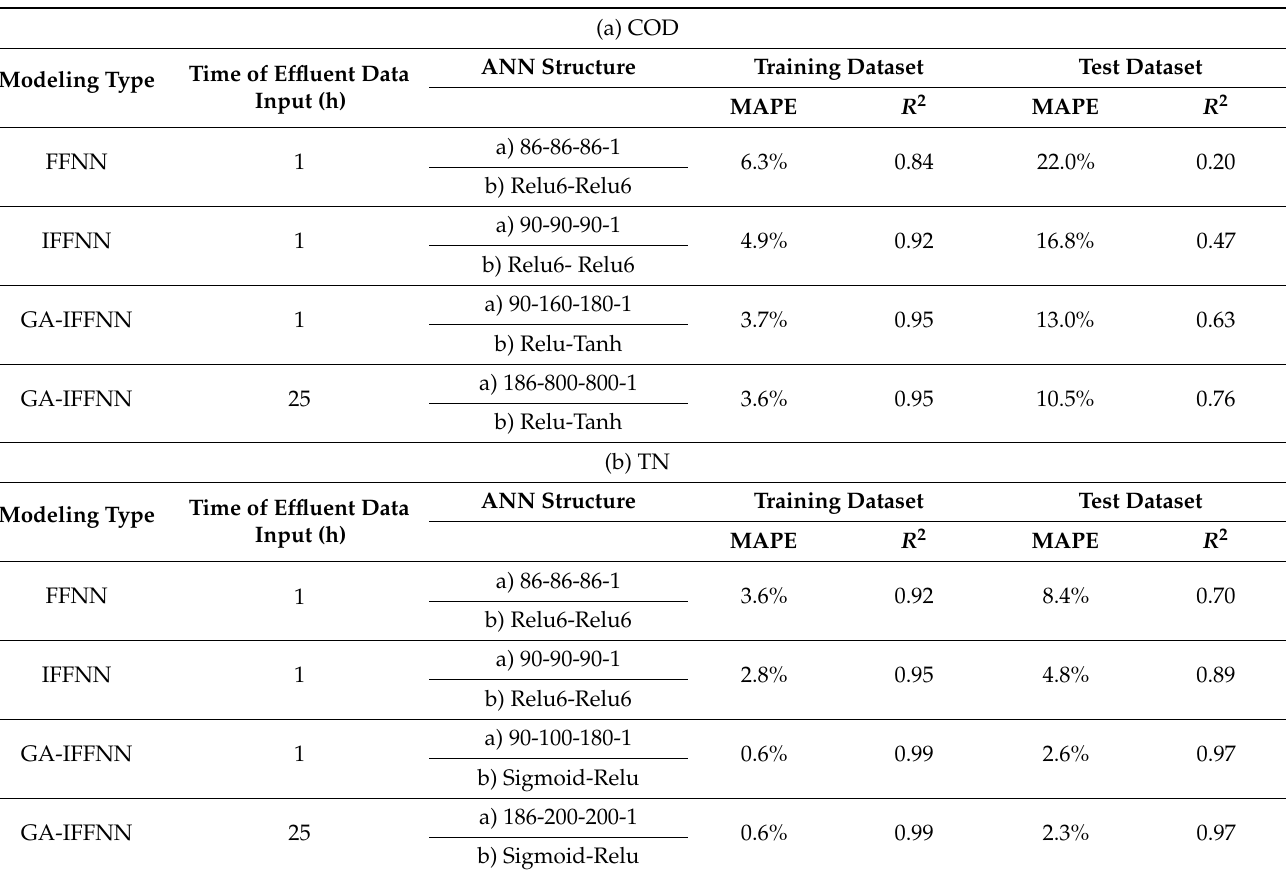
Table 2. Modeling structures and performances for the predicted WWTP effluent water